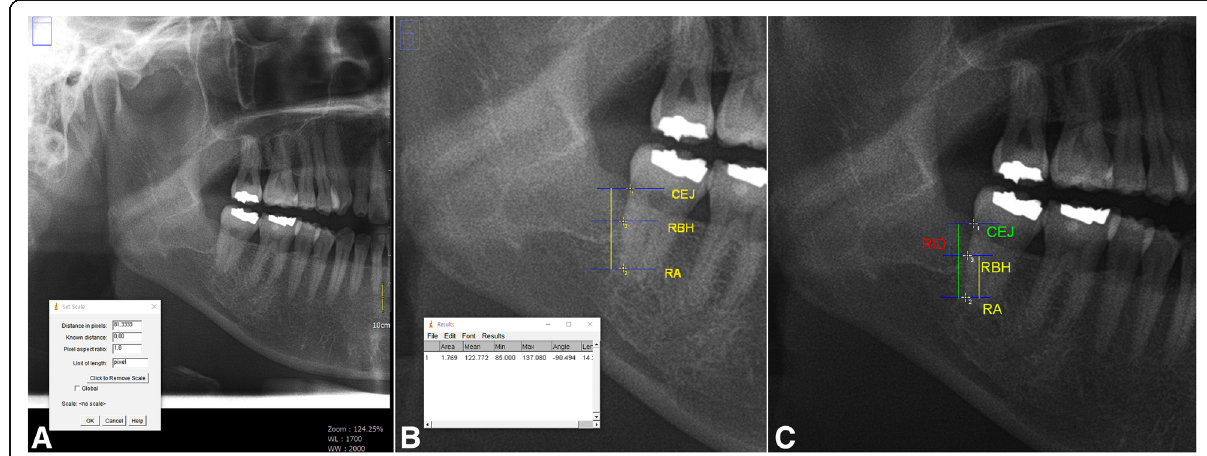
Fig. 2 Panoramic radiograph screening using imageJ® software. a The process of setting the distance per pixel unit using the scale tool in the ImageJ® software and the ruler in the panoramic image. b The process of measuring the desired linear distance in the region of interest (ROI) using the set scale value. c Reference points and radiographic variables: (1) CEJ; (2) root apex of the distal root (RA); (3) Uppermost intersecting point between distal root of M2 and mesial wall of extraction socket; RBH, Radiographic bone height (yellow line); distance between CEJ and RA (green line); RID, Radiographic infrabony defect (red